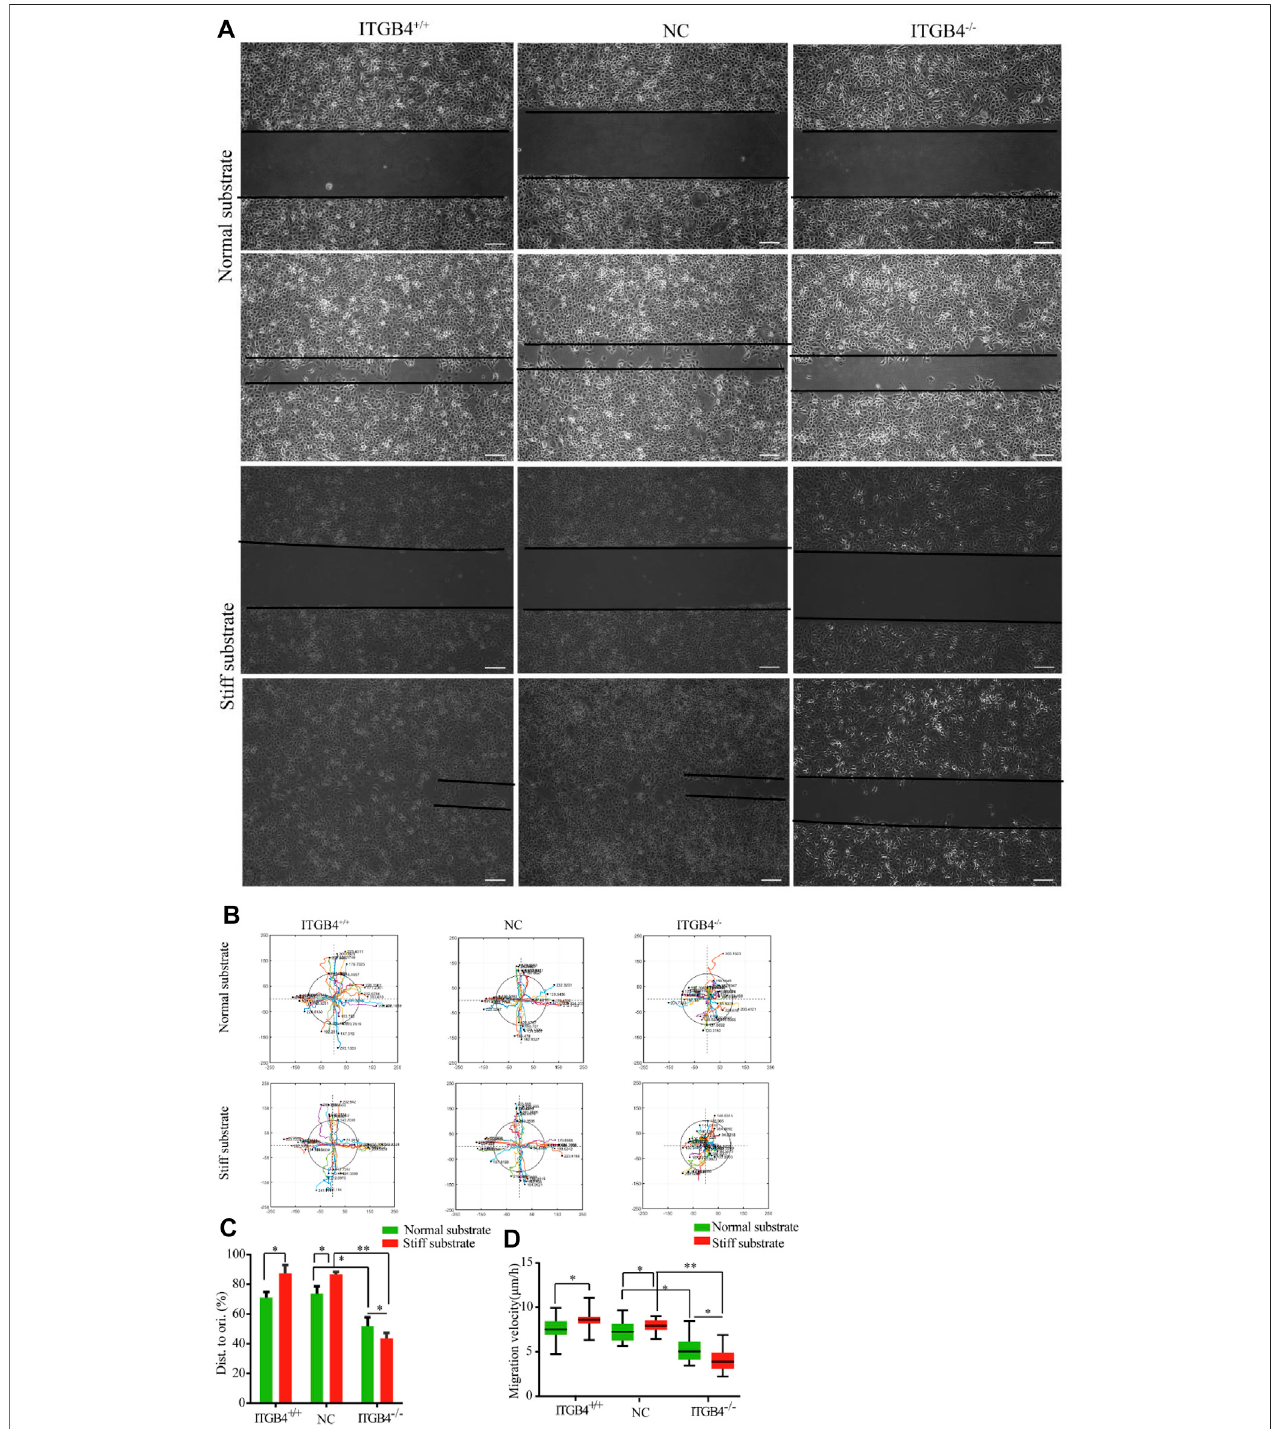
FIGURE6| Cellswoundrepaironthenormalandstiffsubstrates. (A) Representativeimagesofwound-healingofcellsonthenormalandstiffsubstrates. (B) Track migration of cells cultured on the normal and stiff matrix, monitored for 24 h ( n = 40). Tracks were recorded in the x / y direction. Each value indicates the total distance travelled by the cells in 24 h; the line colors reveal the trajectory of different cells; the colors were randomly assigned. (C) Quanti fi cation of the rate of repair at 24 h post- injury(relativeto0 h, n =40). (D) Box-and-whiskerplotofcellmigrationvelocity( n =40).( n =3independentexperiments,* p < 0.05;** p < 0.01).Dataarepresented as mean ± SD.